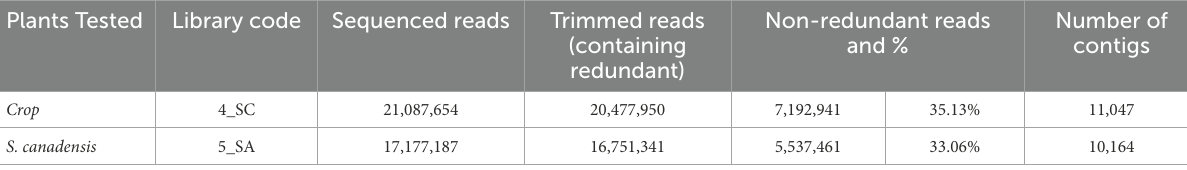
Non-redundant reads and %